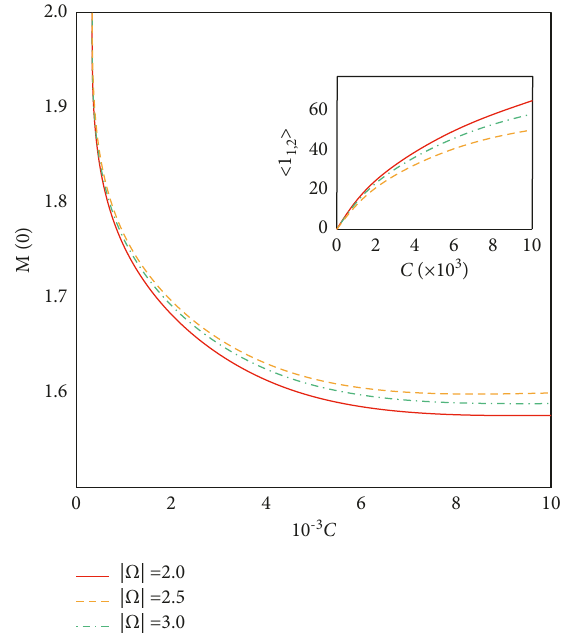
Figure 4: Variation curve of zero-frequency output spectrum M(0) with the change of cooperation parameter